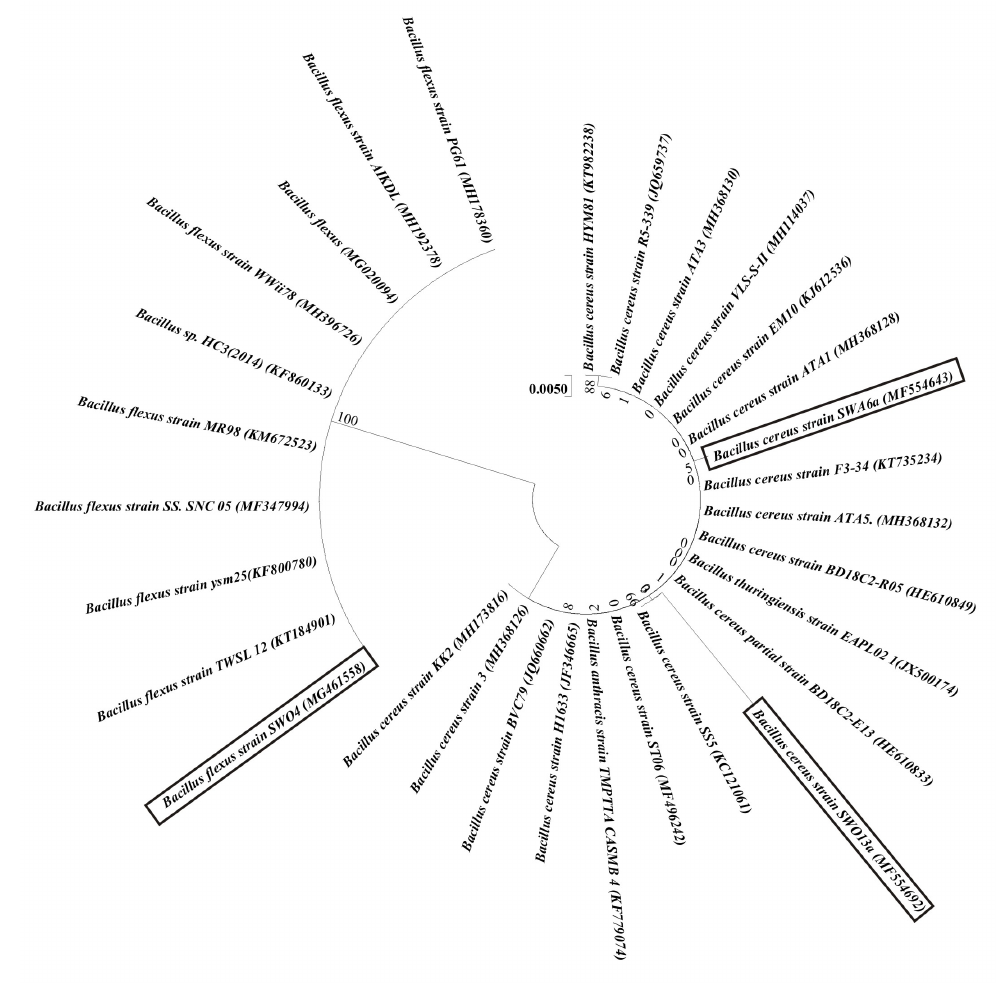
Fig. 3. Evolutionary relationships of the three strains. The Genbank Accession Numbers for each strains used in this analysis is mentioned in parenthesis. The evolutionary history was inferred using the Neighbor-Joining method. The optimal tree with the sum of branch length = 0.10455038 is shown. The tree is drawn to scale, with branch lengths in the same units as those of the evolutionary distances used to infer the phylogenetic tree. The evolutionary distances were computed using the Maximum Composite Likelihood method and are in the units of the number of base substitutions per site. The differences in the composition bias among sequences were considered in evolutionary comparisons. The analysis involved 30 nucleotide sequences. All positions with less than 95% site coverage were eliminated. That is, fewer than 5% alignment gaps, missing data, and ambiguous bases were allowed at any position. There were a total of 829 positions in the final dataset. Evolutionary analyses were conducted in